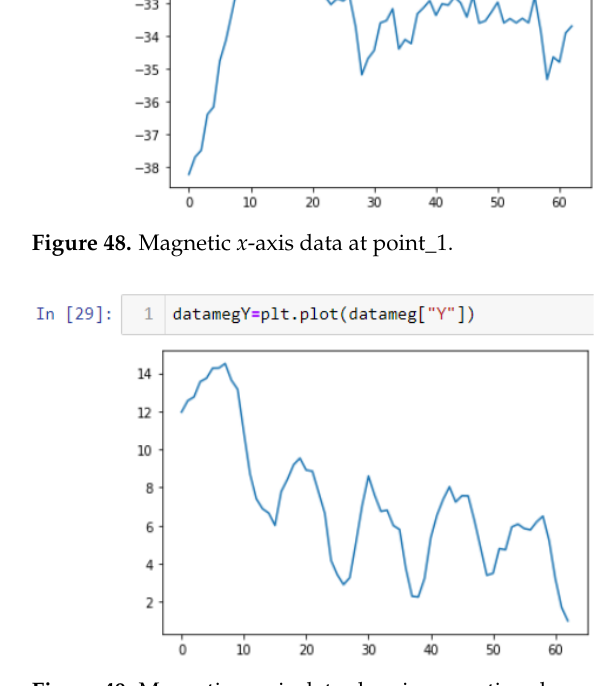
Figure 49. Magnetic y -axis data showing negative slope.